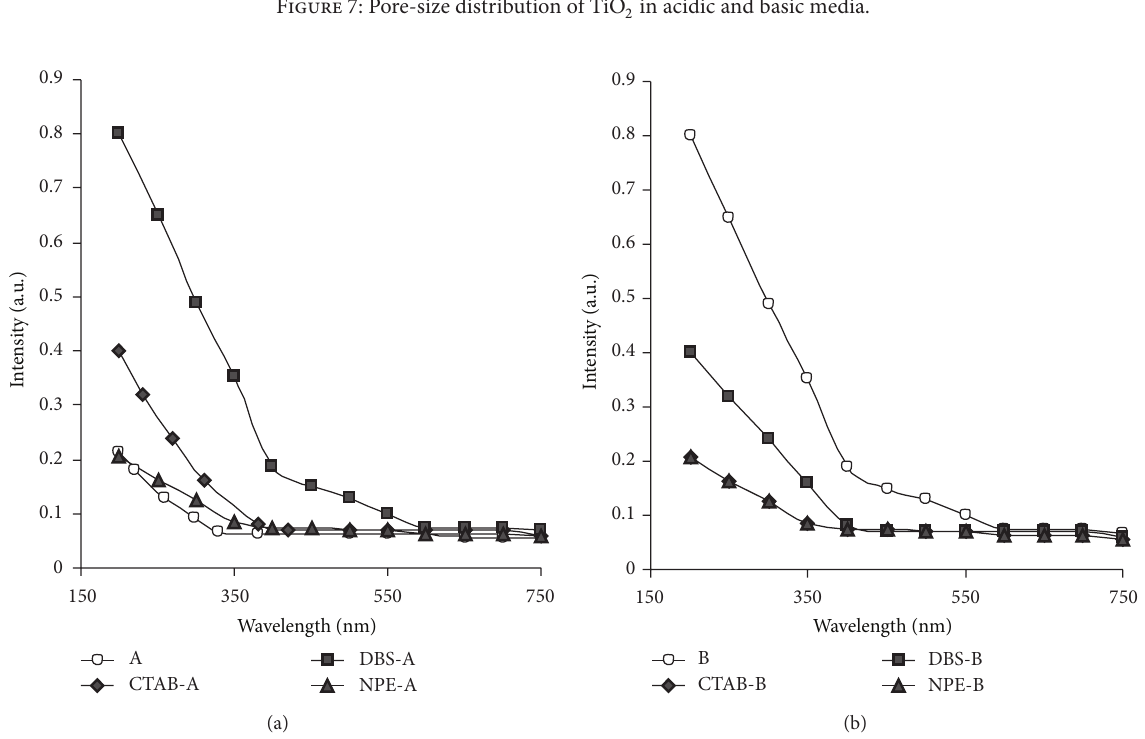
Figure 8: UV-vis absorption spectrum of the TiO 2